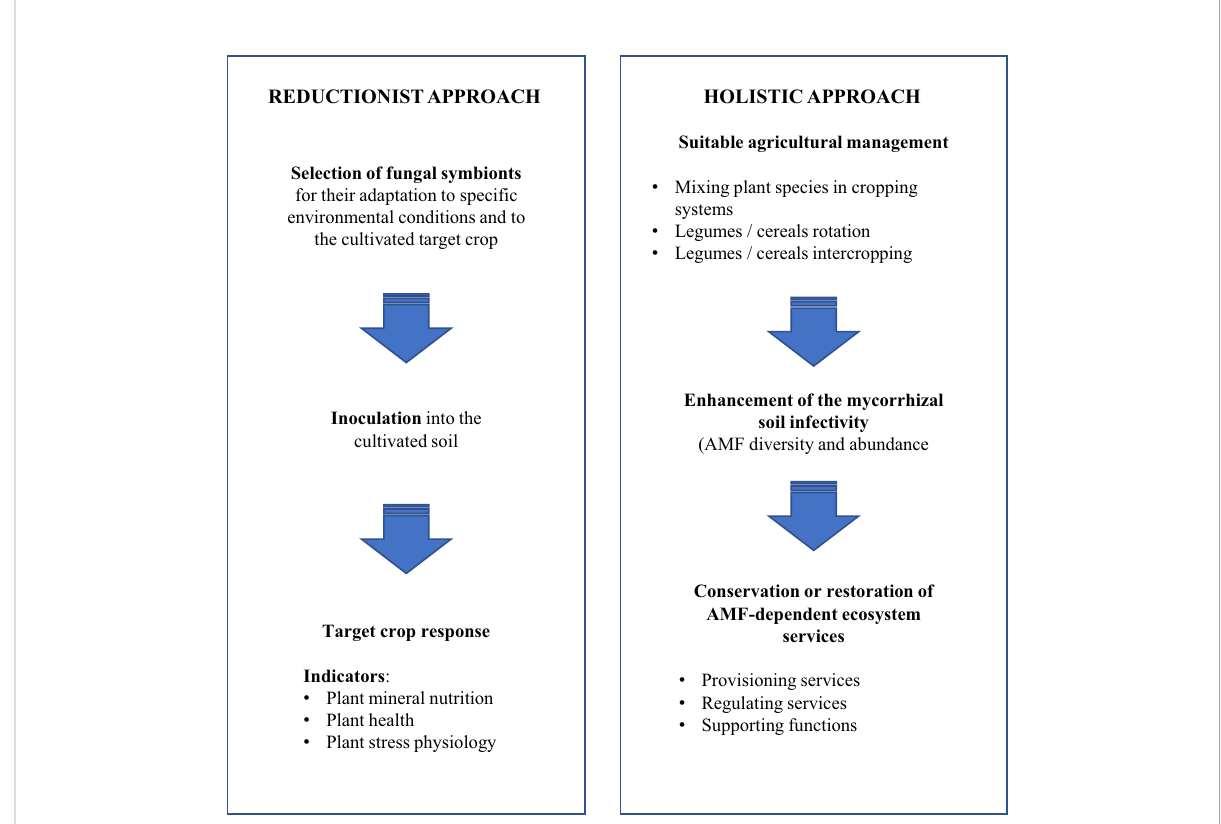
FIGURE 1 Technical approaches to ensure the AMF integration in agricultural practices (Adapted from Fester & Sawers